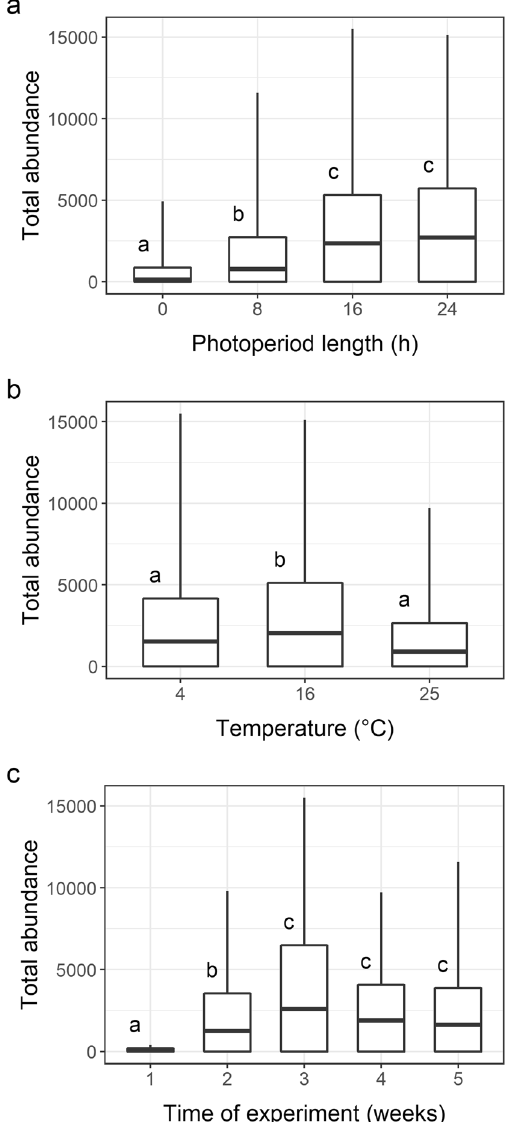
Figure 4. Phytoplankton abundance: ( a ) at different photoperiod lengths, ( b ) at different temperatures, and ( c ) in successive sampling weeks (1–5). The same letters at the boxes denote lack of significant difference ( P ≥ 0.05) between particular groups according to a post-hoc test (whiskers: minimum and maximum values, box: standard deviation, and line: mean; N = 180). The graph was created in R 4.0.4 under RStudio 1.4.1106 using the ‘ggplot2’ package and the data in